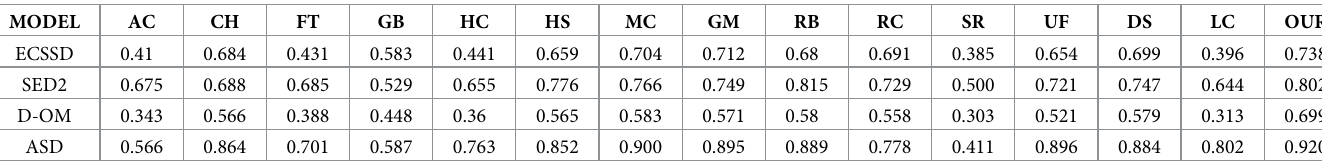
Fig 10. The graphical comparison of our method against the current schemes like: AC [39], CH [44], FT [35], GB [9], HC [10], HS [36], MC [40], GM [5], RB [45], RC [10], SR [43], UF [41], DS [6], LC [42], and our method on the ASD dataset [35]. https://doi.org/10.1371/journal.pone.0213433.g010 Table 1. Comparison of F-score of the proposed model with current